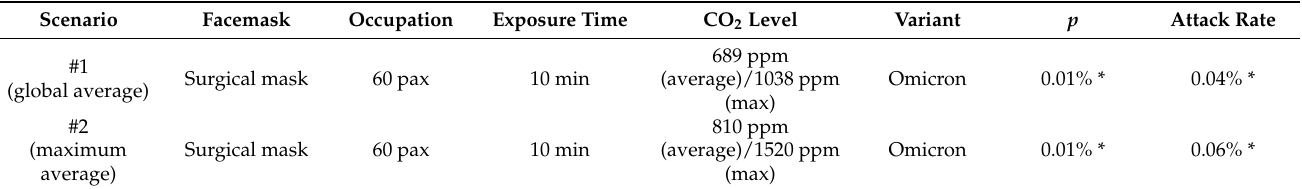
Table 5. Determination of the infection probability and attack rate by aerosols in two different scenarios simulates the Tram’s ventilation conditions, using Covid Risk Airborne [31] based on the model Wells–Riley